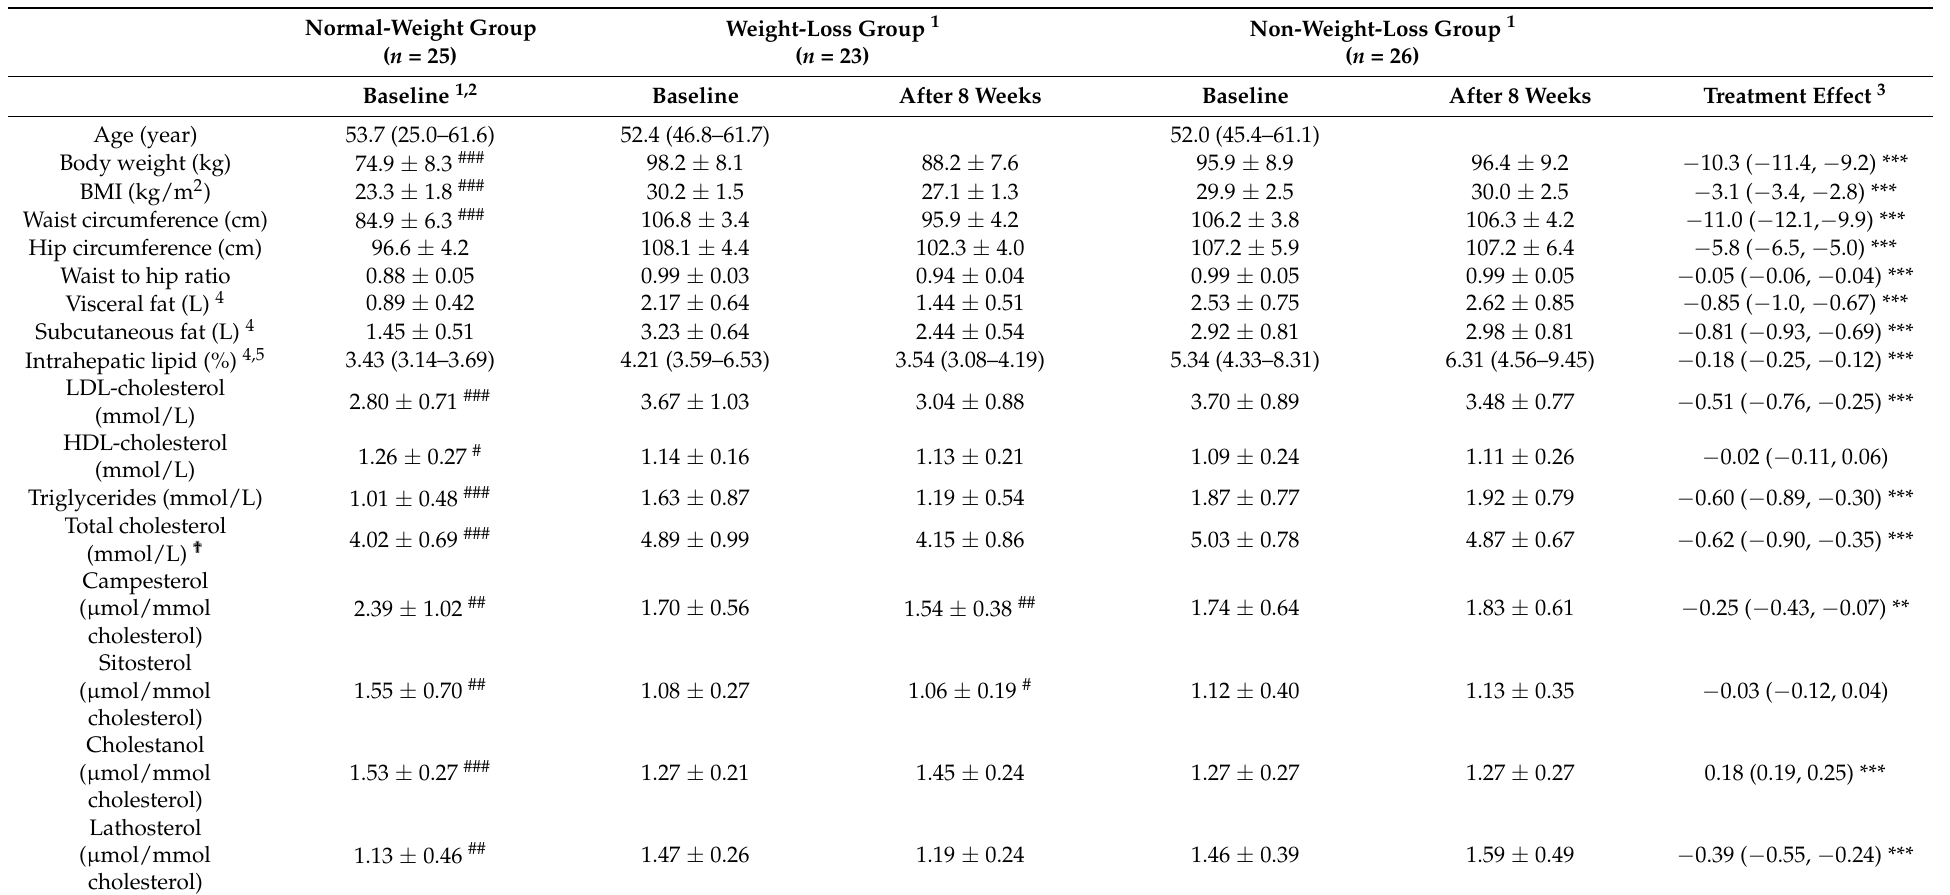
Table 1. Anthropometric characteristics and plasma cholesterol and non-cholesterol concentrations of normal weight and abdominally obese men at baseline and after 8 weeks with diet-induced weight loss or no-weight-loss control